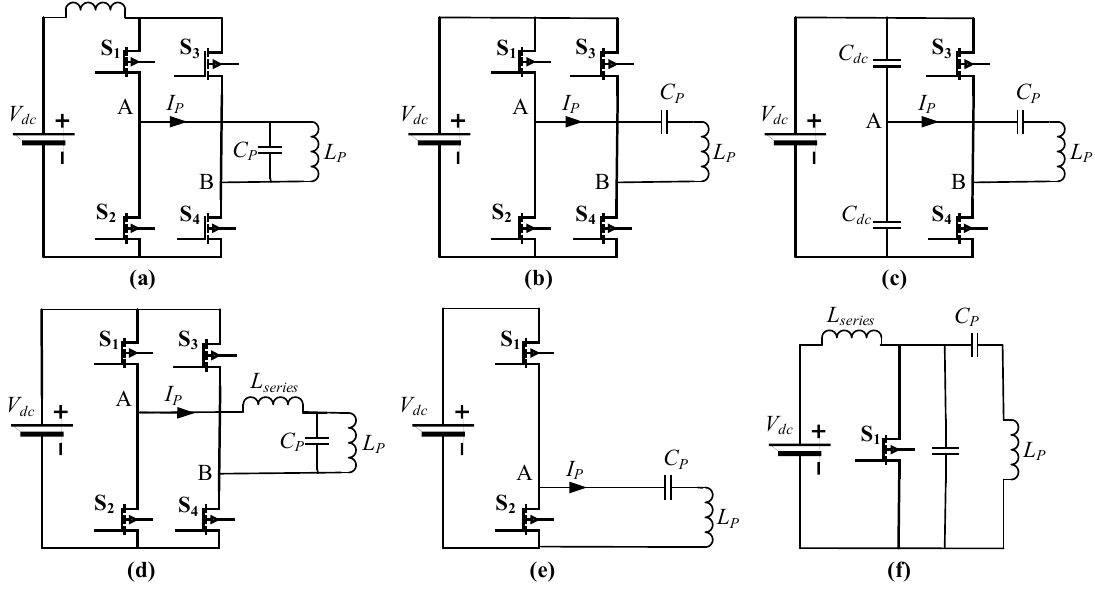
Figure 18. Types of transmitter-side converter: ( a ) current-fed full-bridge converter, ( b ) voltage- fed full-bridge converter, ( c ) voltage-fed half-bridge converter, ( d ) voltage-fed LCL converter, ( e ) voltage-fed class D amplifier, and ( f ) current-fed class E RF amplifier.